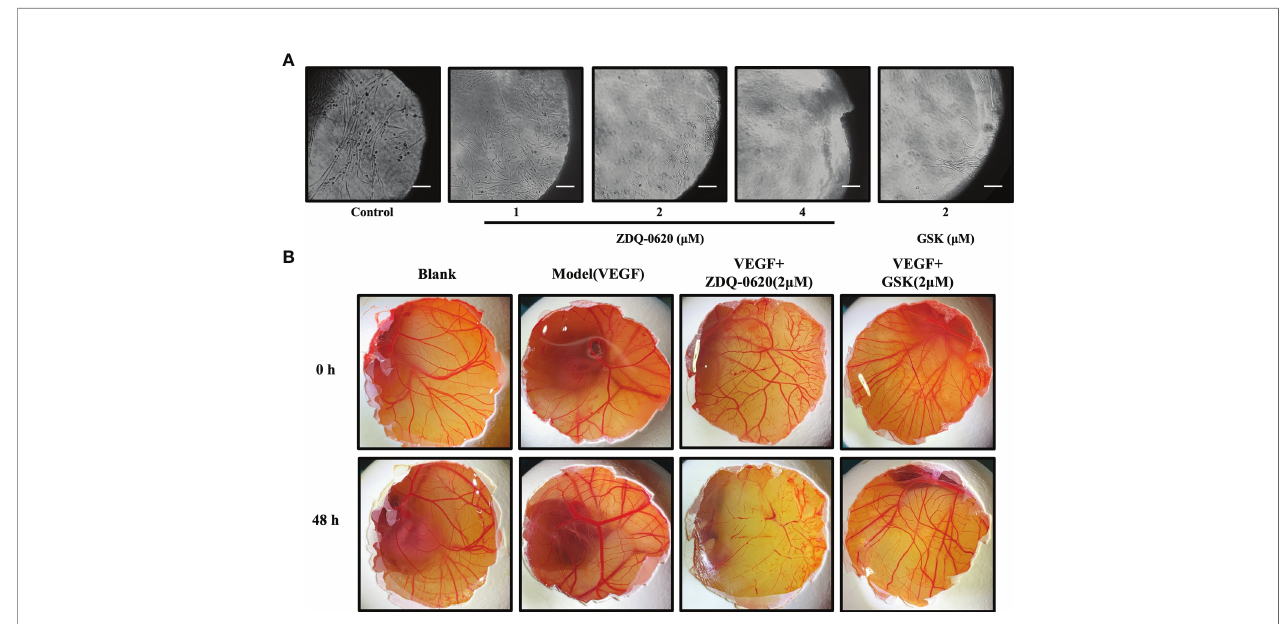
FIGURE 8 | ZDQ-0620 inhibits angiogenesis ex vivo and in vivo . (A) ZDQ-0620 inhibited microvascular sprouting in rat aortic rings; scale bar, 100 m m. (B) Chicken eggs were treated with vehicle, VEGF (50 ng/mL), or VEGF+ZDQ-0620 or GSK2126458. Representative images from separate experiments are shown. All experiments were repeated three